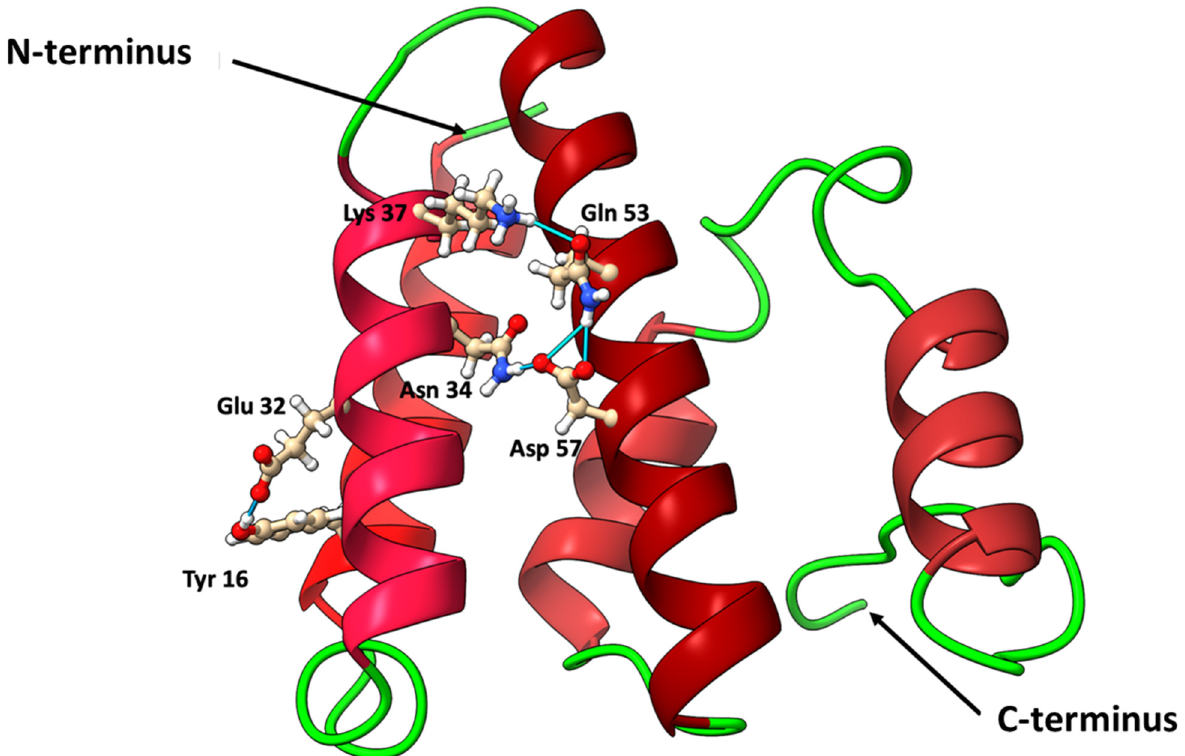
Figure 2. AlphaFold2 predicted structure of lacticaseicin 30 showing five helices (various shades of red) connected by coil regions (green). Five predicted H-bonds (blue) stabilize the position of the three helices.